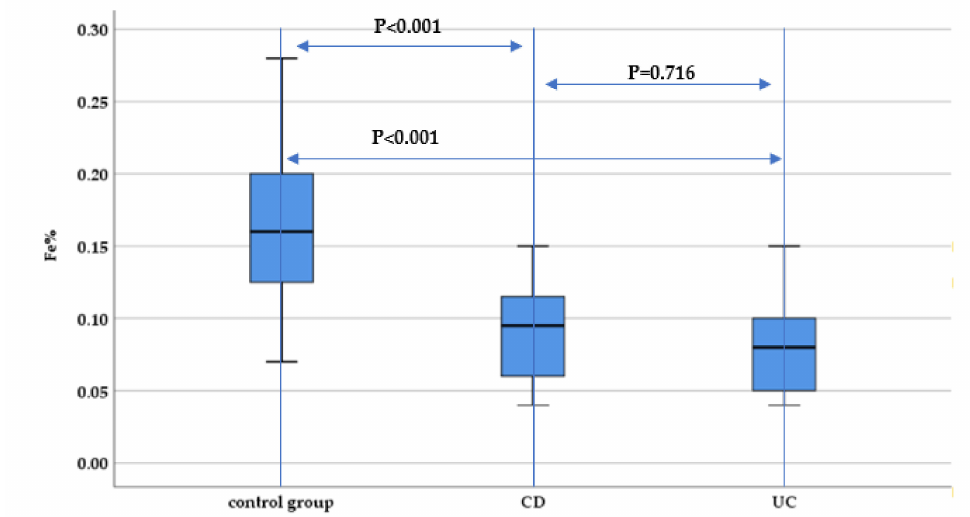
Figure 5. Evaluation of hair iron concentration (Fe%) between IBD subtypes (UC and CD) and the control group. When evaluating copper hair concentration, we identified significantly lower con- centrations among CD patients compared to the control group ( p = 0.015). There was no statistically significant difference between UC and CD patients regarding hair copper concentration ( p = 0.462) (Figure 6).